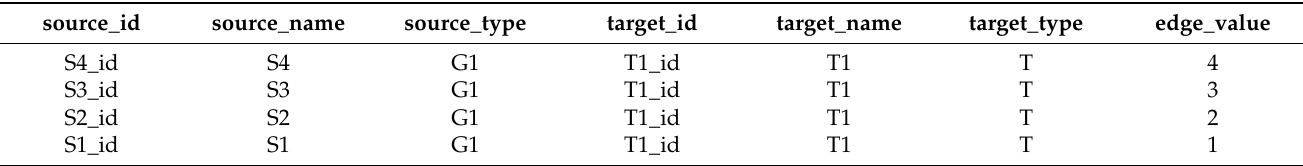
Table 4. A display of the first input data example manipulated to fit CompositeView’s final data input